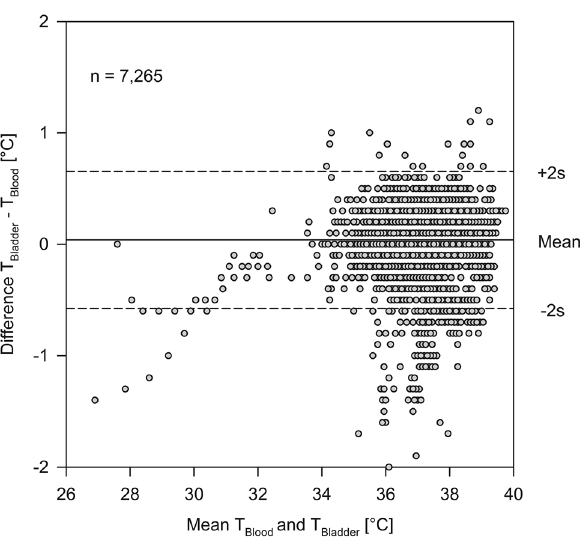
Figure 2. Bland–Altman analysis for bladder temperature (T Bladder ) versus blood temperature (T Blood